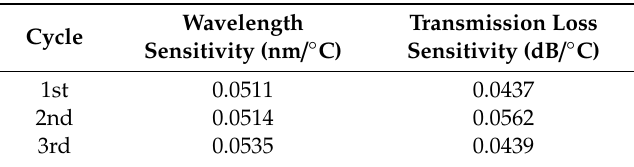
Figure 7. Chart of wavelength loss over three temperature test cycles. Table 2. Wavelength shift and transmission loss sensitivity over three temperature test cycles under LPFG (D = 65 µ m, Λ = 620 µ